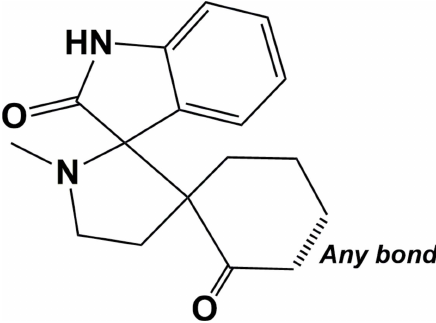
Figure 3 Structural fragment for the CSD